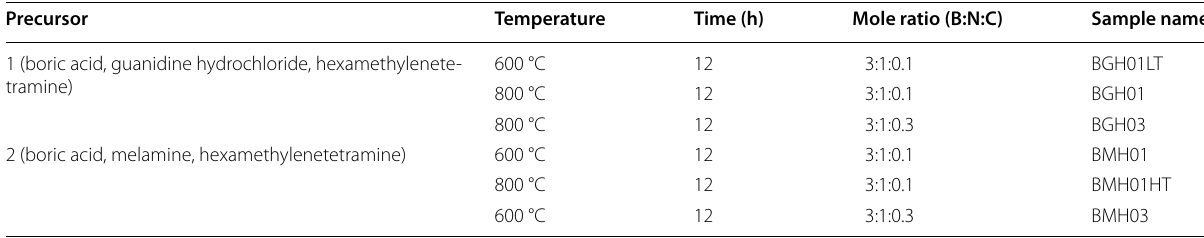
Table 1 Precursor sources, ratios, annealing temperatures, and times for the preparation of BGH and BMH series